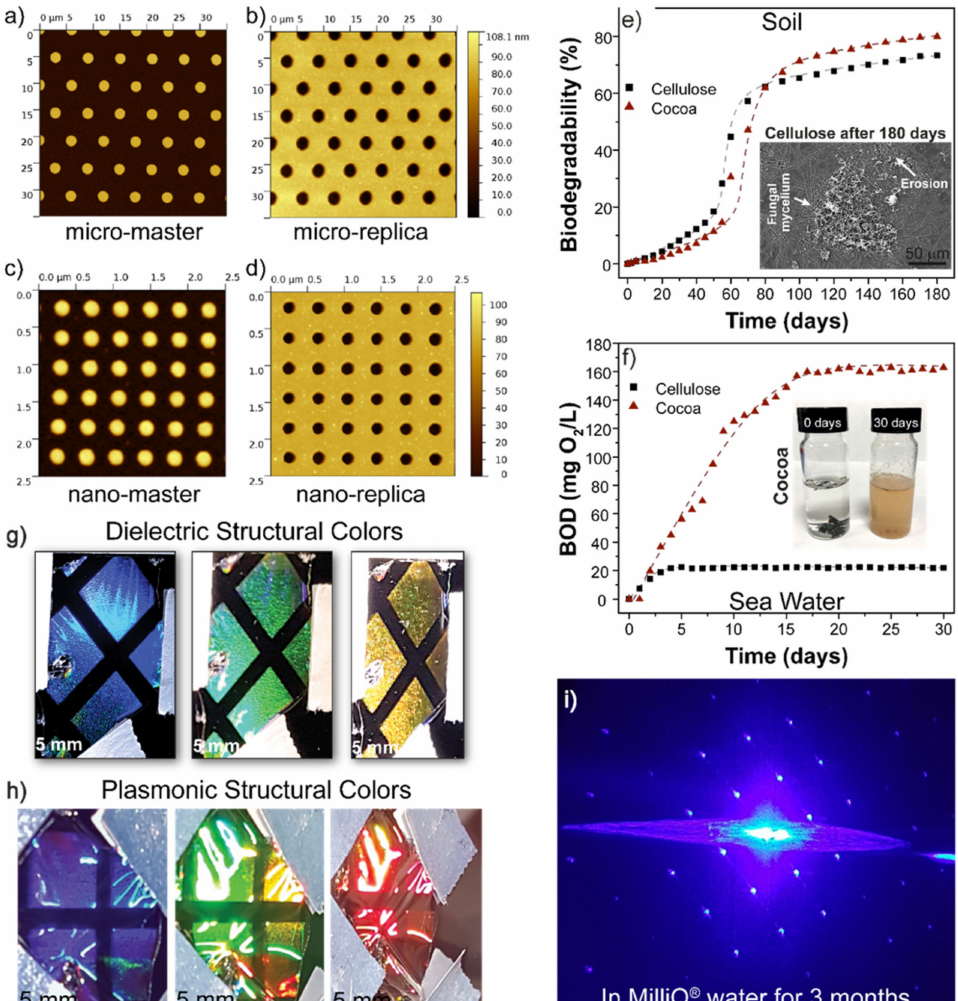
Figure 7. Cellulose Micro- and Nano-Devices : Solid-state micro- ( a ) and nano-scale ( c ) masters with the respective micro- ( b ) and nano-scale ( d ) cellulose replicae. Biodegradability in ( e ) soil and ( f ) sea water. ( g ) Dielectric and ( h ) plasmonic colors obtained by the structure in panel ( d ), for the dielectric case, and by the metallization of the same structure, for the plasmonic case. ( i ) Stability of the cellulose photonic crystal in panel ( b ) in MilliQ water for a three-month immersion. Reproduced with permission from reference [94]. [Copyright 2020, American Chemical